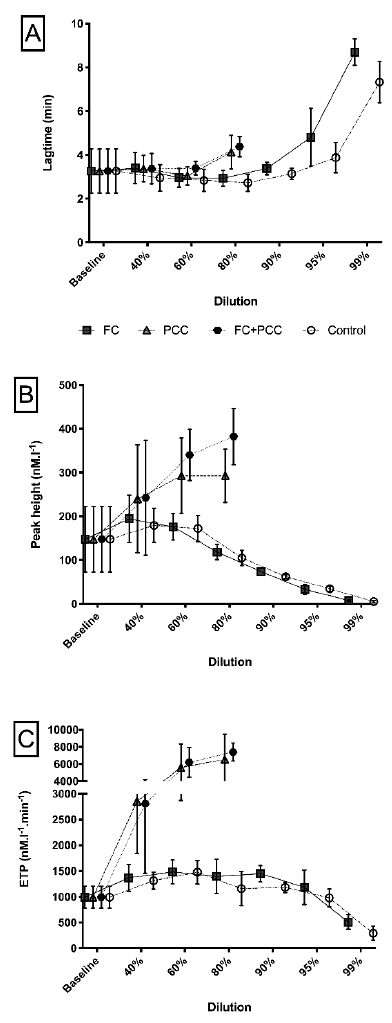
Figure 4. ( A ) Lagtime, ( B ) peak height, and ( C ) endogenous thrombin potential in a comparison between the four study groups and di ff erent dilution levels. ( A ) Significant di ff erences ( p < 0.05) between the groups containing PCC (PCC, FC + PCC) and those that did not (FC, Control) occurred at the 80% dilution level. ( B ) Within the groups containing PCC, FC + PCC showed significantly